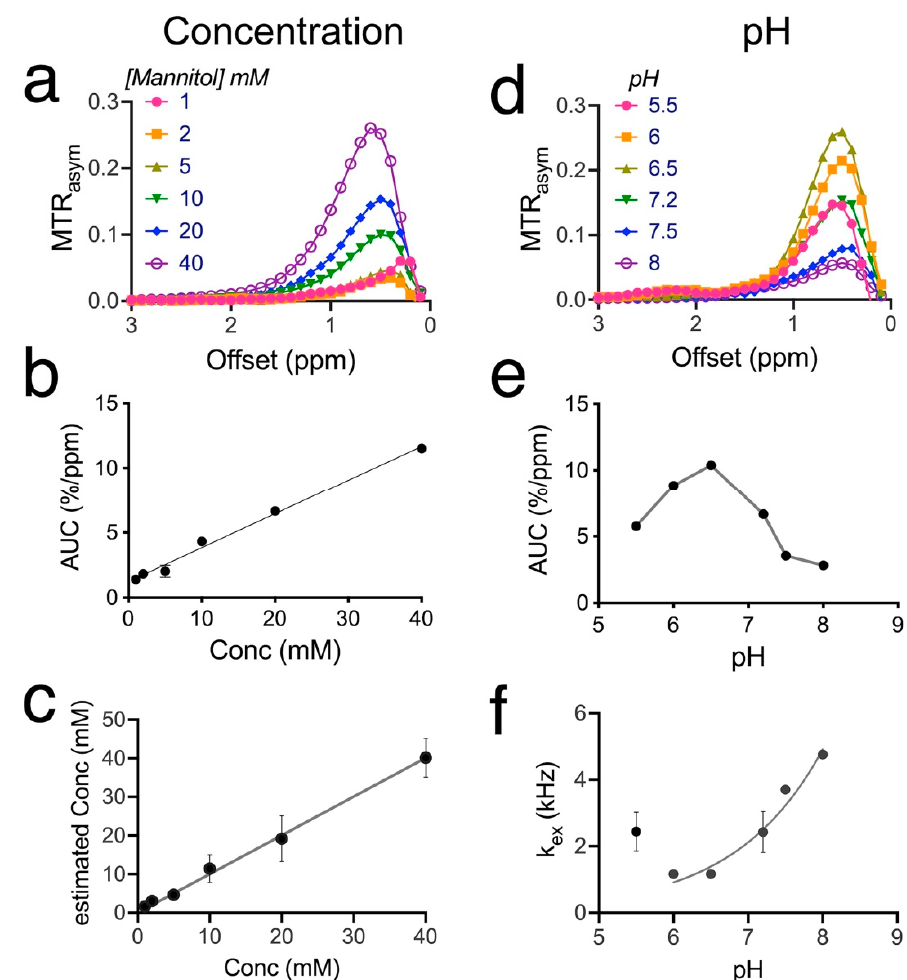
Figure 2. Concentration and pH dependence of the CEST MRI contrast of mannitol at 11.7T (37 °C). ( a ) MTR asym plots of mannitol at concentrations ranging from 1 to 40 mM (pH 7.2 in PBS). ( b ) Concentration dependence of mannitol CEST contrast as quantified by AUC (0.2–2 ppm). ( c ) Linear correlation between the concentrations estimated using Bloch equation fitting and the nominal concentrations. ( d ) MTR asym plots of mannitol solutions as a function of pH (20 mM in PBS). ( e ) pH dependence of mannitol CEST contrast as quantified by AUC (0.2–2 ppm). ( f ) Exchange rates of hydroxyl protons as a function of pH. Unless otherwise noted, all CEST experiments were acquired using a RARE sequence (TR/TE = 6000/5 ms) and a CW saturation pulse (B 1 /T sat = 1.8 µT/4 s).